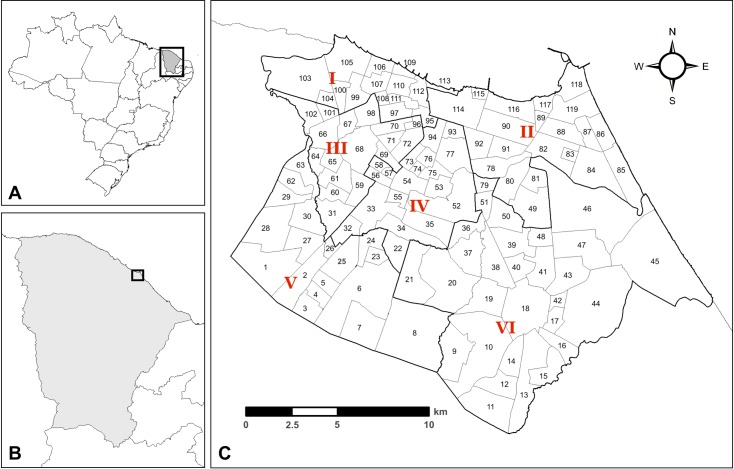
Administrative districts of Fortaleza, Ceará, Brazil.A: Brazil state boundaries; B: Ceará state; C: Fortaleza municipality. Red numerals (I-VI) refer to Fortaleza regionais (districts), numbers refer to bairros (neighborhoods). A bairro name key is included in supplementary material (S1 Table).